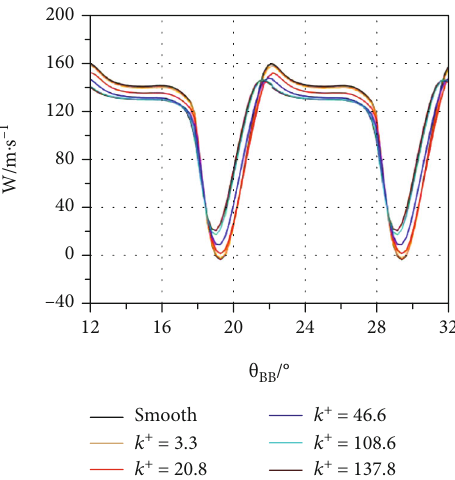
Figure 16: The wake velocities of the rotor at 50% span height at di ff erent k +